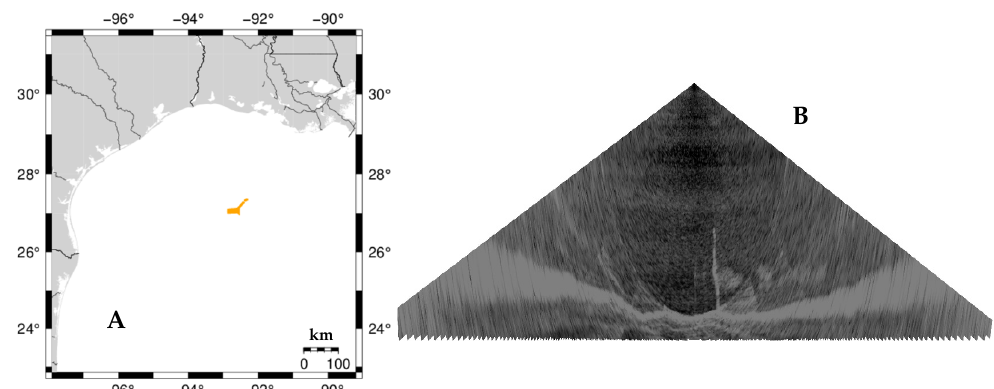
Figure 19. Multibeam water column data in Gulf of Mexico. ( A ) is the track lines, and ( B ) shows a multibeam images of this measurement.